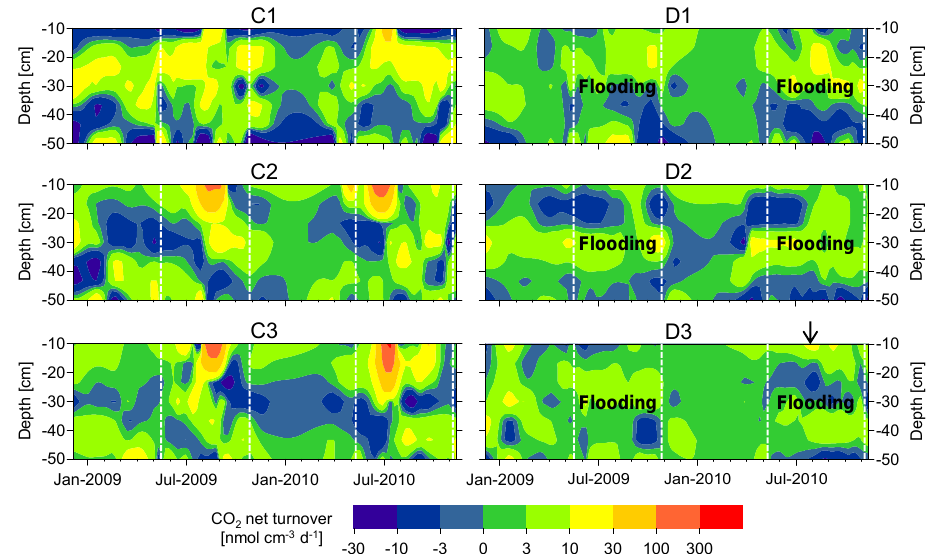
Fig. 7. Net turnover of CO 2 along soil profiles in the control and flooded plots. Dashed white lines indicate start and end of the flooding periods during the growing seasons in 2009 and 2010. The arrow in D3 points to the date with an exceptional high soil CO 2 efflux due to interrupted flooding.